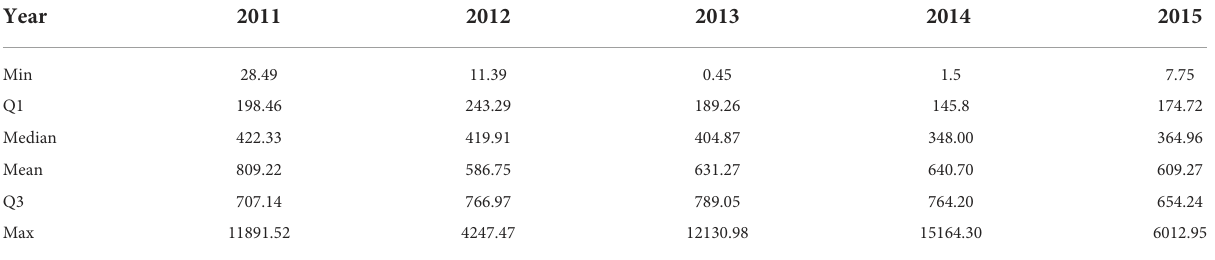
TABLE 2 Summary statistics of severities per claim for 2011–2014 for the 2011 cohort.